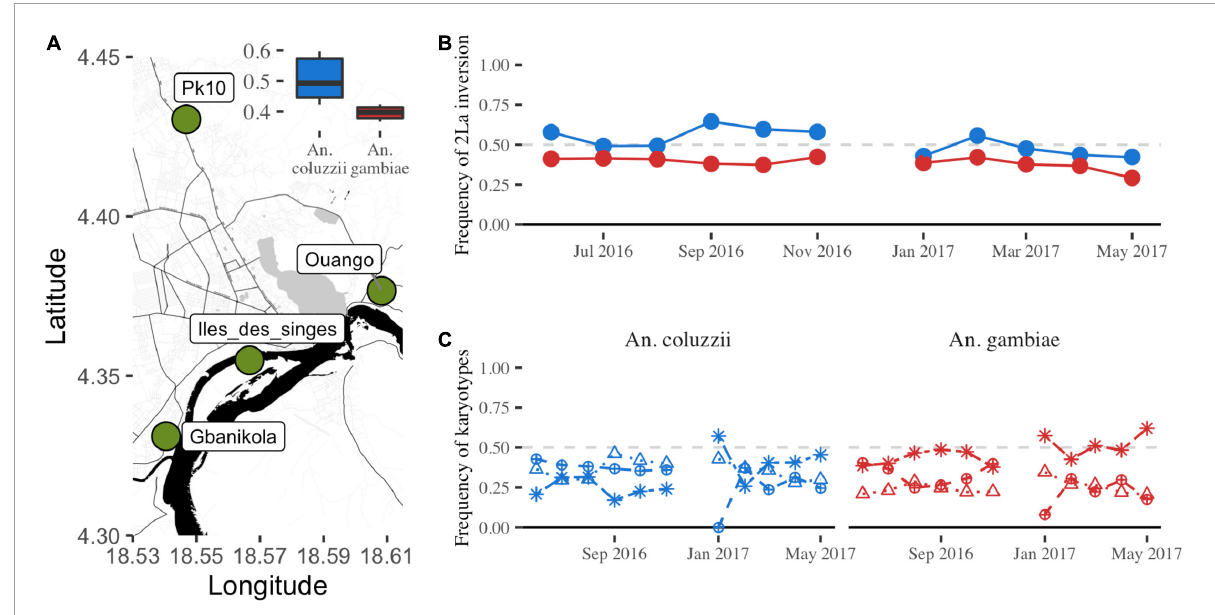
FIGURE1 Collection sites and temporal dynamics of the 2La inversion frequency in Bangui. (A) Green circles indicate the mosquito collection sites in the city of Bangui (source: https://OpenStreetMap.org). The inset shows the mean frequency of the 2La inversion in the two species during the collection year. (B) Linear representation of the 2La inversion frequency variations for each species (blue line, A. coluzzii ; red line, A. gambiae ) during the collection year. (C) Linear representation of each karyotype (mean frequency) per species across the year. Blue lines, A. coluzzii ; red lines, A. gambiae . Asterisks, standard karyotype; circles with a cross, heterozygote karyotype; triangles, inverted